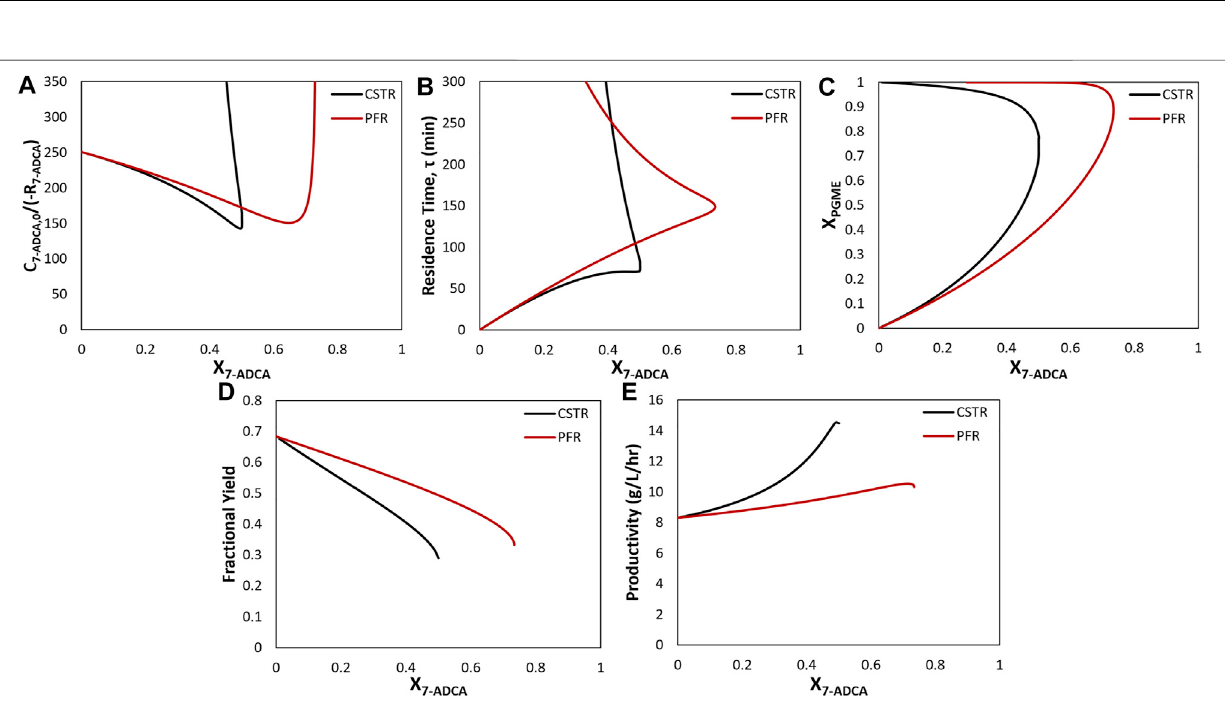
Frontiers in Bioengineering and Biotechnology |